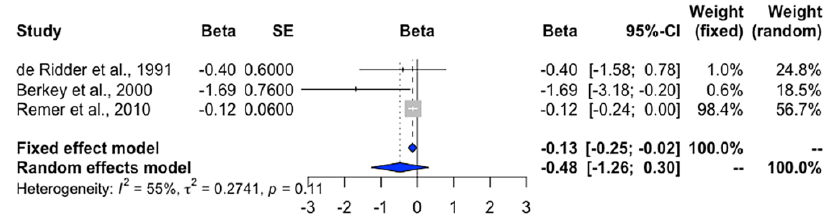
Figure 5. Forest plot of the beta regression coefficient of age at menarche onset for every 1 g/day increase of animal protein intake. Definition of abbreviations : Beta, beta coefficient; SE, standard error.